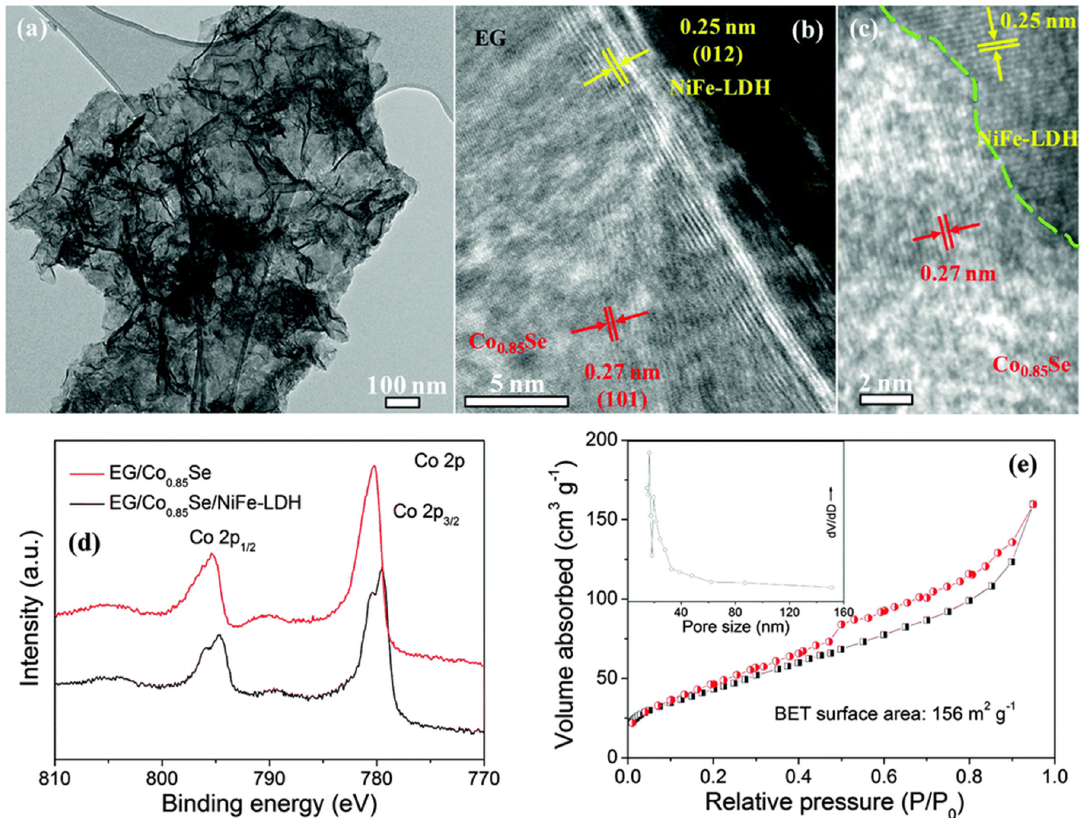
Figure 5. TEM ( a ) and HRTEM ( b , c ) images of EG/Co 0.85 Se/NiFe − LDH. ( d ) High ‐ resolution Co 2p XPS spectra of EG/Co 0.85 Se and EG/Co 0.85 Se/NiFe − LDH. ( e ) N 2 adsorption isotherm and the corresponding pore size distribution (inset) of EG/Co 0.85 Se/NiFe − LDH. Reprinted with permission from Ref. [98]. Copyright 2016 The Royal Society of Chemistry.